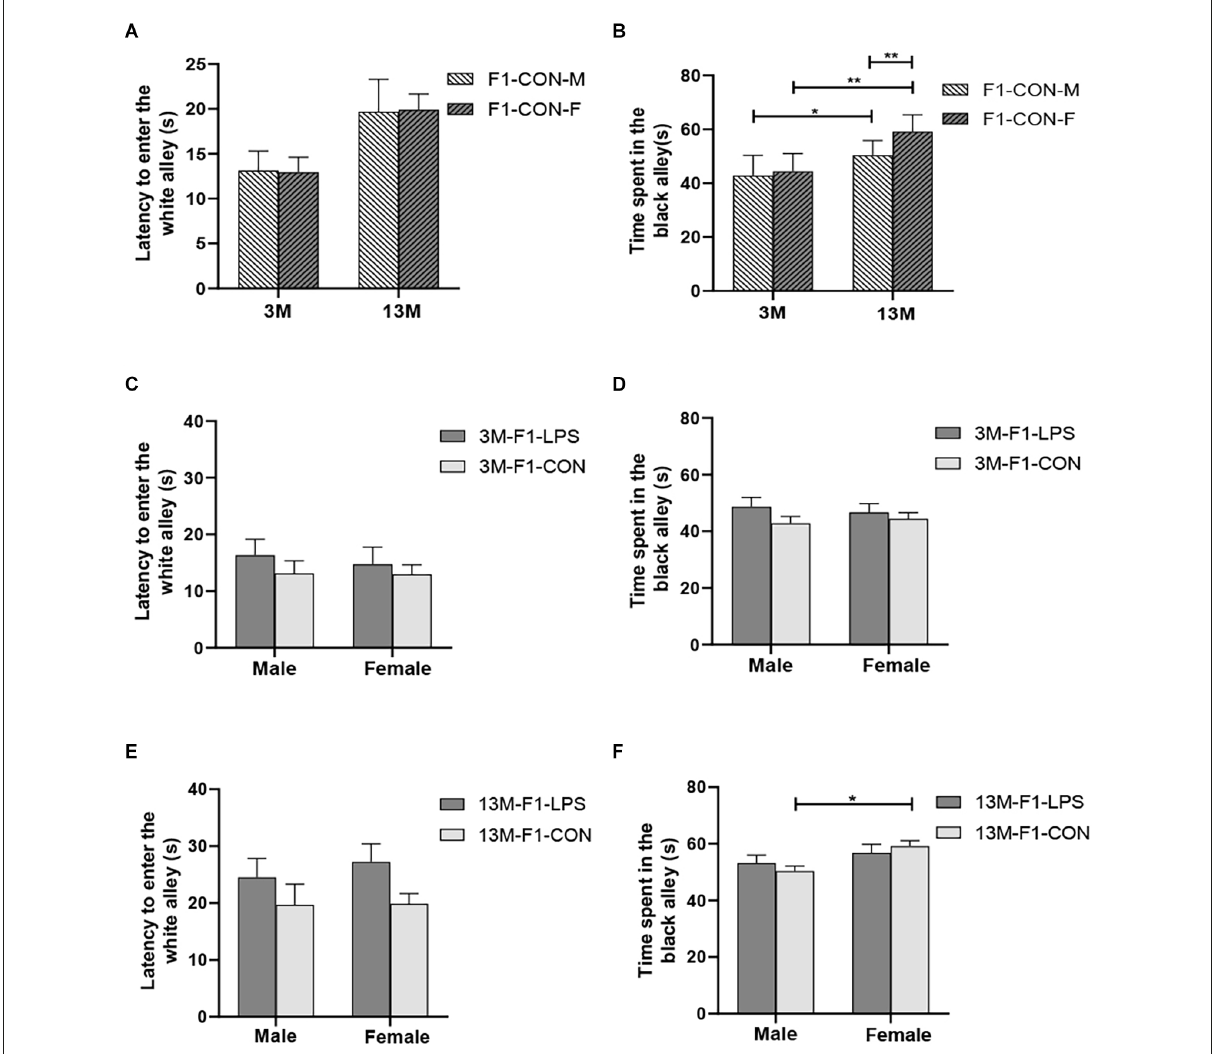
FIGURE4 The results of the black–white alley test in the F1 generation. (A,B) Latency before entering the white alley, time spent in the black alley at different ages in the control groups. n = 10 male or female mice/group. Error bars = standard error of the mean (SEM); * P < 0.05, ** P < 0.01 compared with the 3-month-old (3 M) group. (C,E) Latency before entering the white alley and (D,F) time spent in the black alley for 3- (3 M) and 13-month- old (13 M) CD-1 mice in the different treatment groups; n = 10 male or female mice/group. Error bars = SEM. * P < 0.05. CON-M, male mice exposed to saline in utero ; CON-F, female mice exposed to saline in utero ; F1-CON, F1 mice exposed to saline in utero ; F1-LPS, F1 mice exposed to prenatal inflammation.